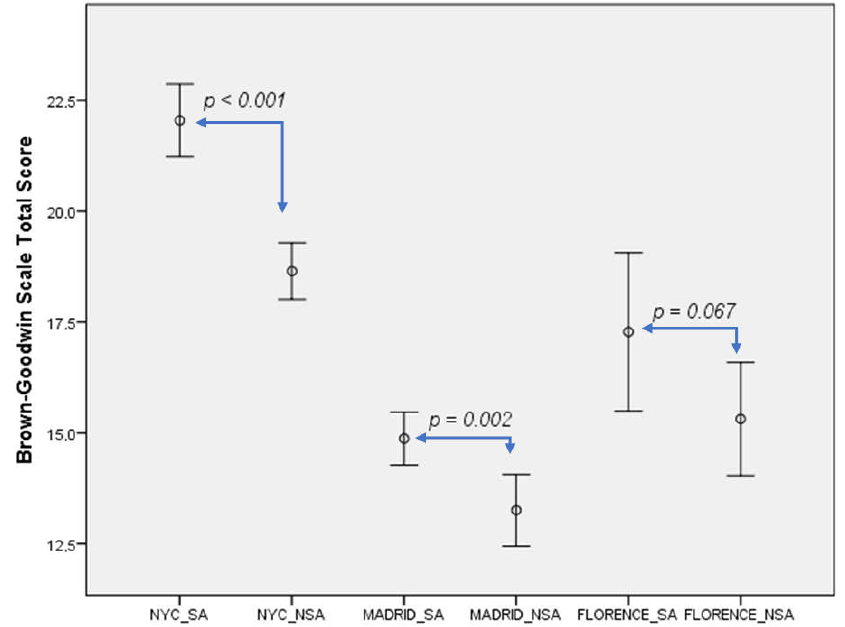
Figure 1. Aggression levels differences between suicide attempters and non-attempters across sites. NYC: New York City. SA: Suicide-attempters. NSA: non-suicide attempters.